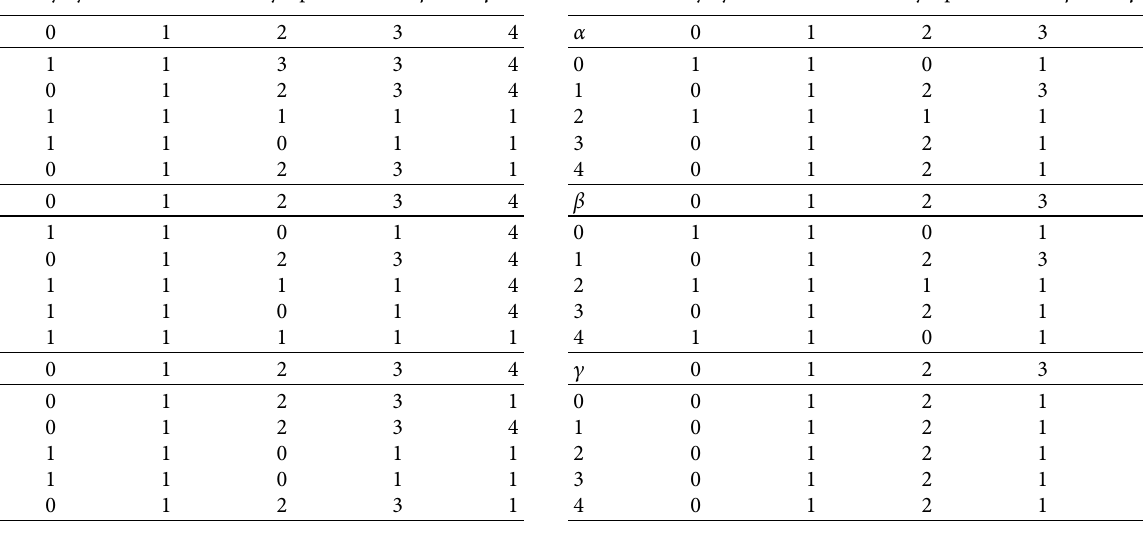
Table 7: Cayley tables for the binary operations “ α , β , and c .” Table 8: Cayley tables for the binary operations “ α , β , and c .”